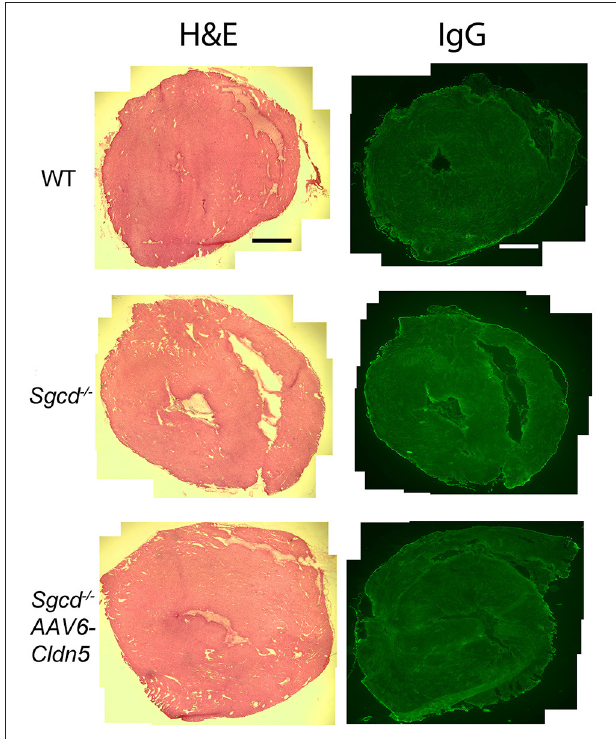
FIGURE 3 | Representative transverse heart sections from WT, Sgcd − / − , and Sgcd − / − AAV6-Cldn5 mice stained with hematoxylin and eosin (H&E) (left) or for IgG (right) . No cardiac damage or fibrosis was observed in any of the three groups of mice at 20 weeks-of-age as assessed by the uptake of serum IgG into myocytes or overall histology. Bar = 500 µ